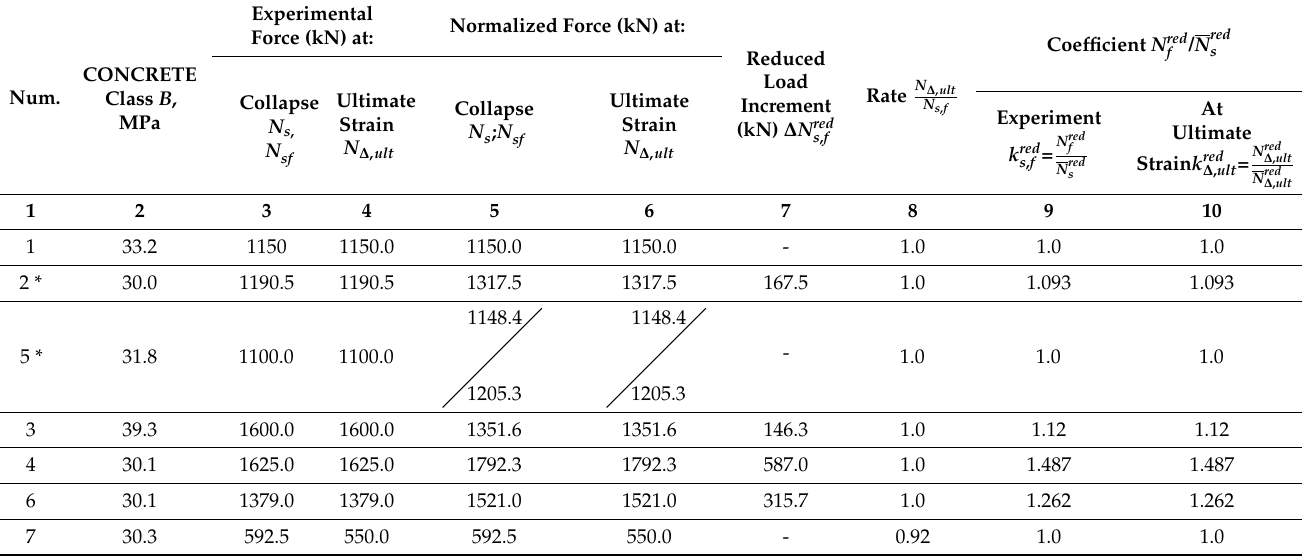
Table 5. Comparison of the reduced experimental strength of reference and reinforced columns when changing variants for external composite